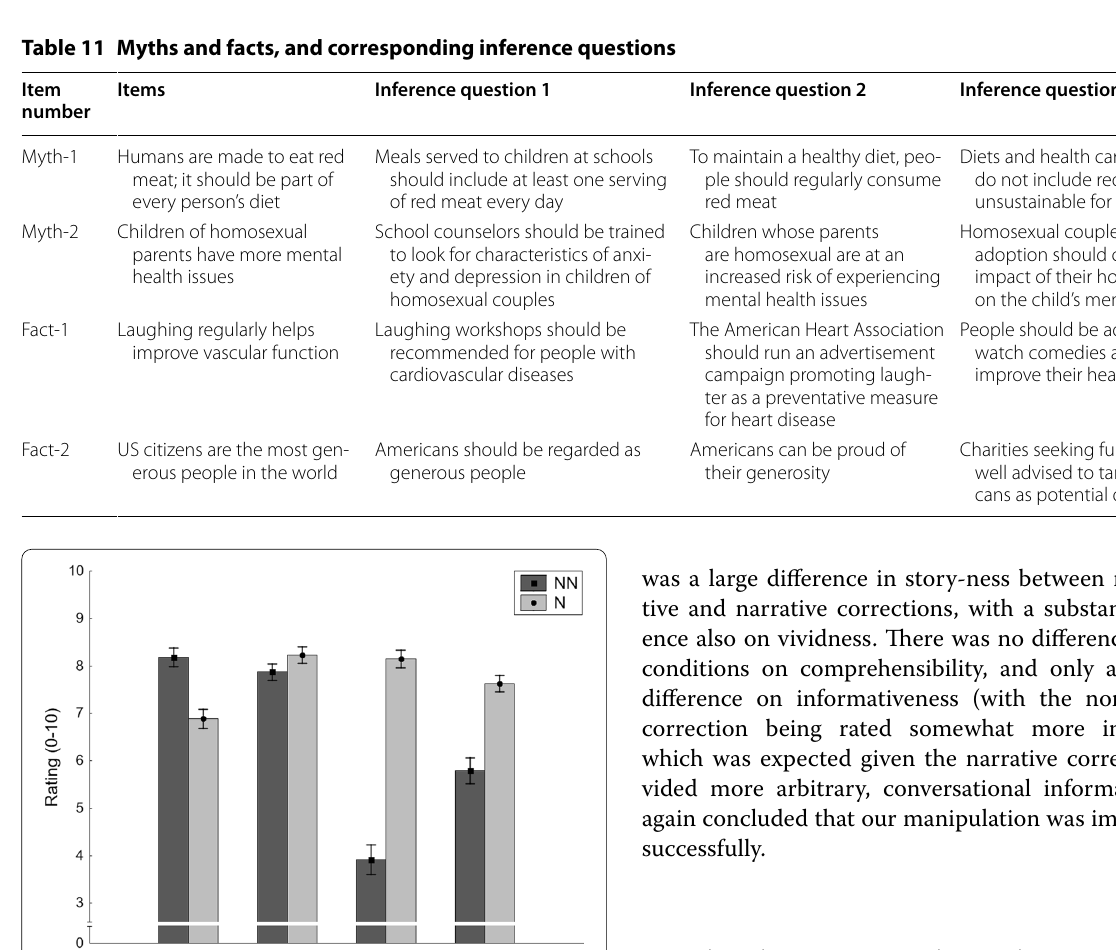
WC, Word Count; FRE, Flesch Reading Ease; FKGL, Flesch–Kincaid Grade Level